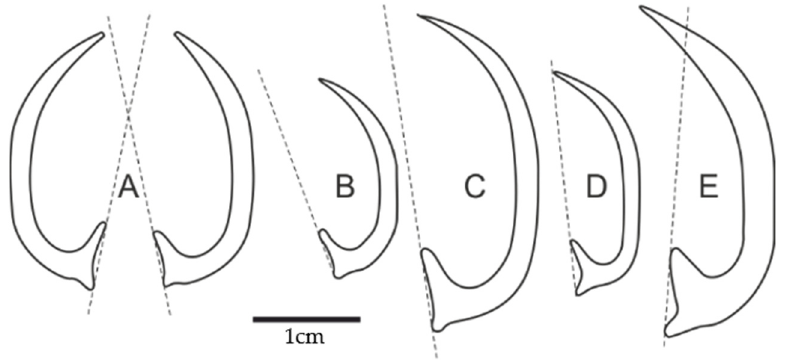
Figure 5. Shapes of published O. barbatus ( A – D ) and described specimen ( E ). Pair of onychites from original Fraas slab of kalk (SMNS/24210—[11], Taf. 5 Figure 1,3, left—lectotype) ( A ); smaller specimen from the same slab ( B ); SMNS/63852 ([11], Taf. 6 Figure 5) ( C ); Quenstedt specimen ([3], Taf. 2, Figure 3) ( D ). Because of poor visibility in the illustrations and possible deformations due to the thickness of the bases, the orientations of the baseline are uncertain; thus, for better comparison, all specimens are oriented with the straight middle section vertically. Scale bar, 1